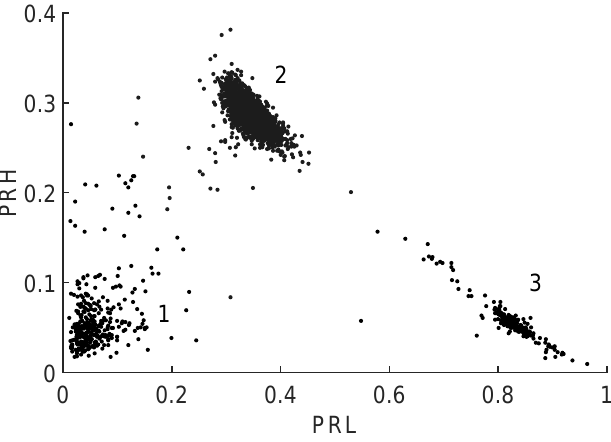
Figure 12. 2D map of the three separated clusters corresponding to the VHF experiment.